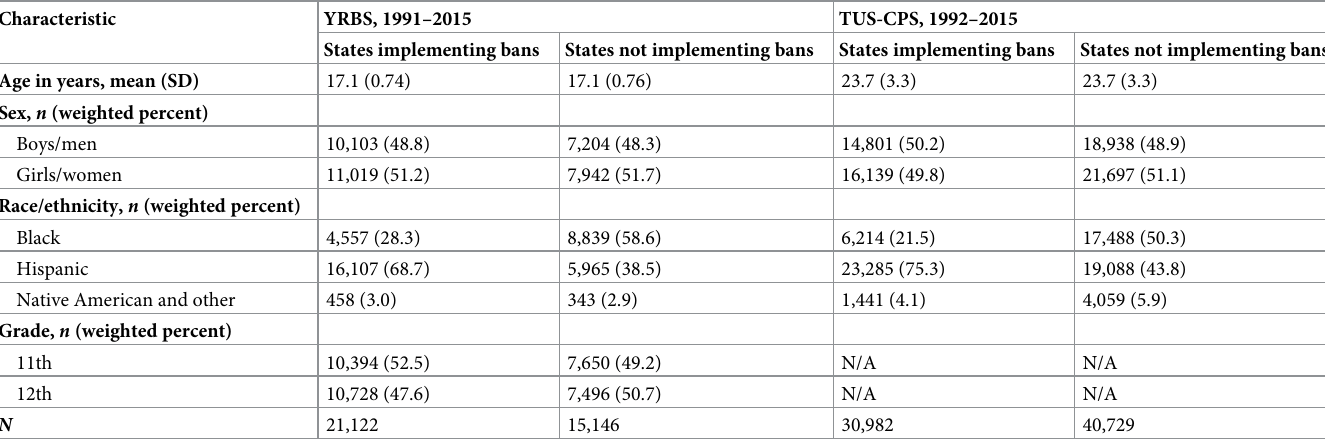
Table 1. Descriptive statistics for YRBS and TUS-CPS study